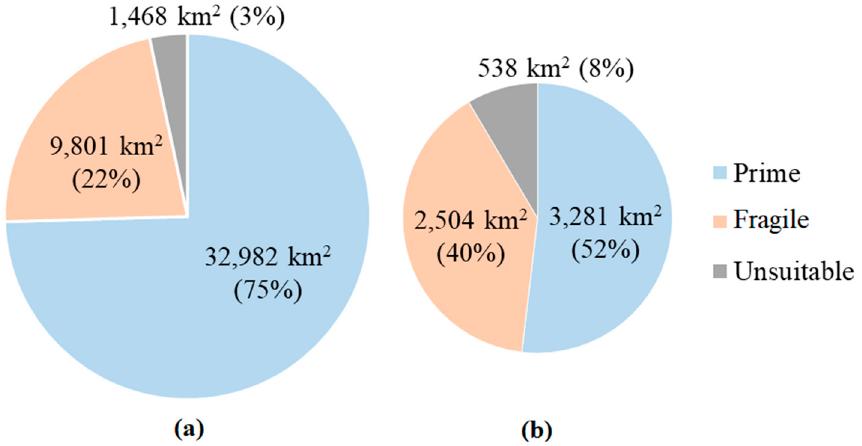
Figure 5. Areas (km 2 ) in ( a ) stable cropland and ( b ) converted cropland by Land Capability Class from the Soil Survey Geographic Database (SSURGO).